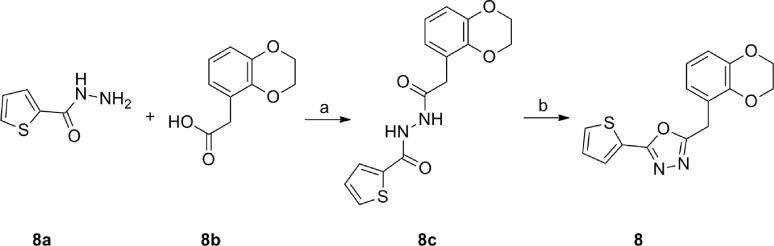
Synthesis of compound 8. Reagents and conditions: (a) EDC, HOBt, DMF; (b) POCl3, 110 °C.